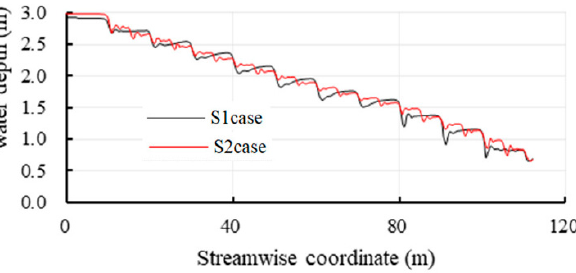
Figure 17. Comparison of water surface profiles between the two schemes. The water head drop in Case S 1 ranges from 0.3 to 0.4 m, which is difficult for migrating fish. However, the flow drops in Case S 2 have been reduced to 0.10 to 0.16 m, forming a minor undulating water surface, which is more suitable for fish migration.